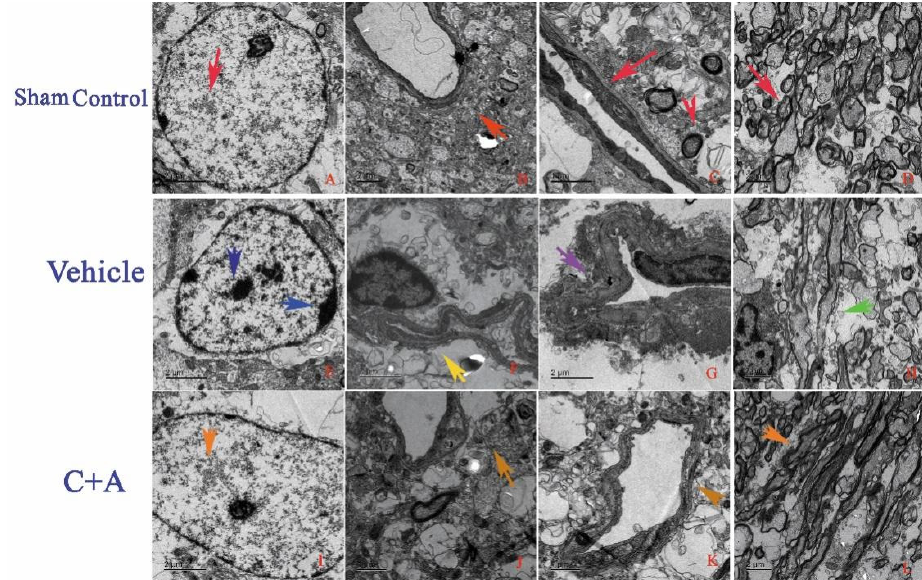
Figure 7. Electron micrographs show the ultrastructural morphology of the ( A – D ) sham control, ( E – H ) vehicle, and ( I – L ) C + A groups. The sham control rats showed ( A ) neuronal nuclei with uncon- densed chromatin (red arrow in ( A )). There was ( B ) no tissue edema or blood vessel leakage. Intact tight junctions (red arrow in ( C )) and myelinated axons surrounded by dark, ring-shaped myelin sheaths were also observed (red arrows in ( C , D )). In the vehicle group, ( E ) neuronal apoptosis was evidenced by shrunken nuclei with marginated, fragmented, and condensed nuclear chromatin (blue arrow in ( E )). ( F ) Severe blood vessel leakage and tissue edema in the extracellular space surrounding the vessels (yellow arrow in ( F )). ( G ) Loosening of tight junctions between the endothelium (purple arrow in ( G )). ( H ) Myelin sheath loosening and splitting (green arrow in ( H )). Treatment with C16 plus Ang-1 reduced morphological changes of the nuclei (orange arrow in ( I )), alleviated perivascular edema (orange arrow in ( J )), prevented destruction of tight junctions (orange arrow in ( K )), and decreased myelin sheath splitting (orange arrow in ( L